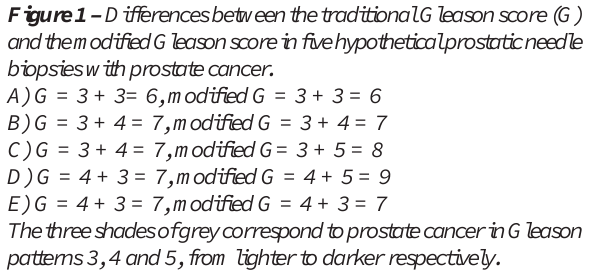
The three shades of grey correspond to prostate cancer in Gleason patterns 3, 4 and 5, from lighter to darker